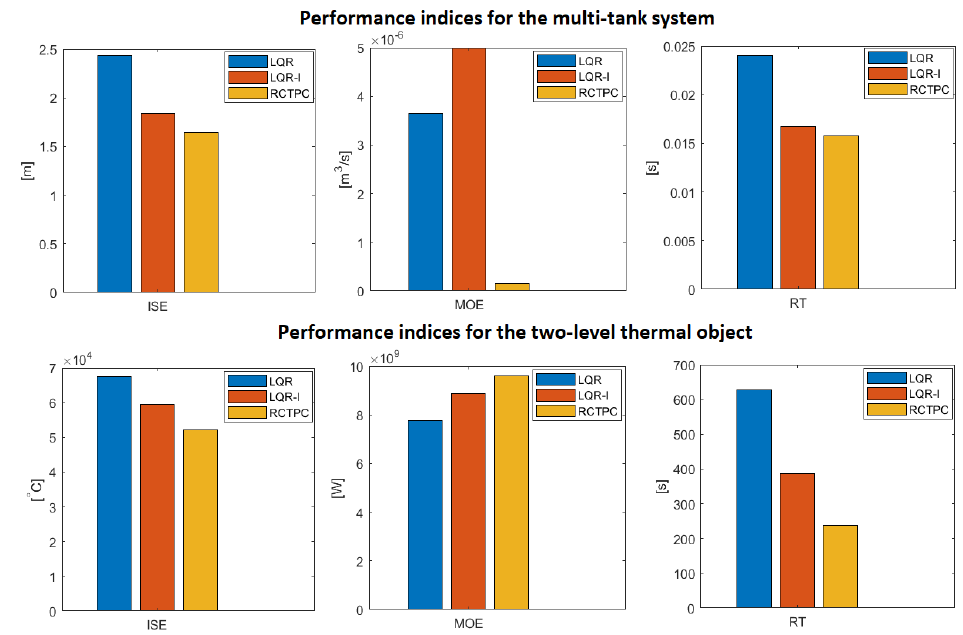
Figure 6. Graphical presentation of Tables 1 and 2 (source: authors).